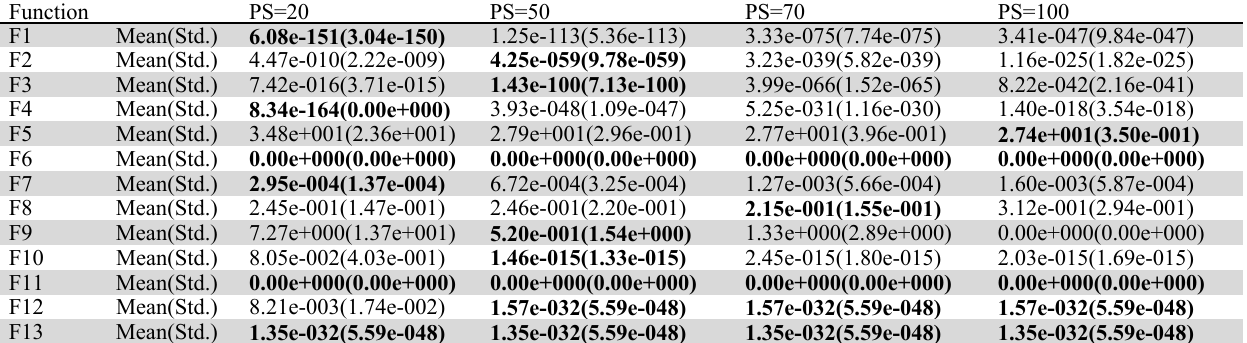
Comparative statistical results of 13 benchmark function of E-BSADE for different values of population size (PS) at D=30 over 25 runs, after 200000 function